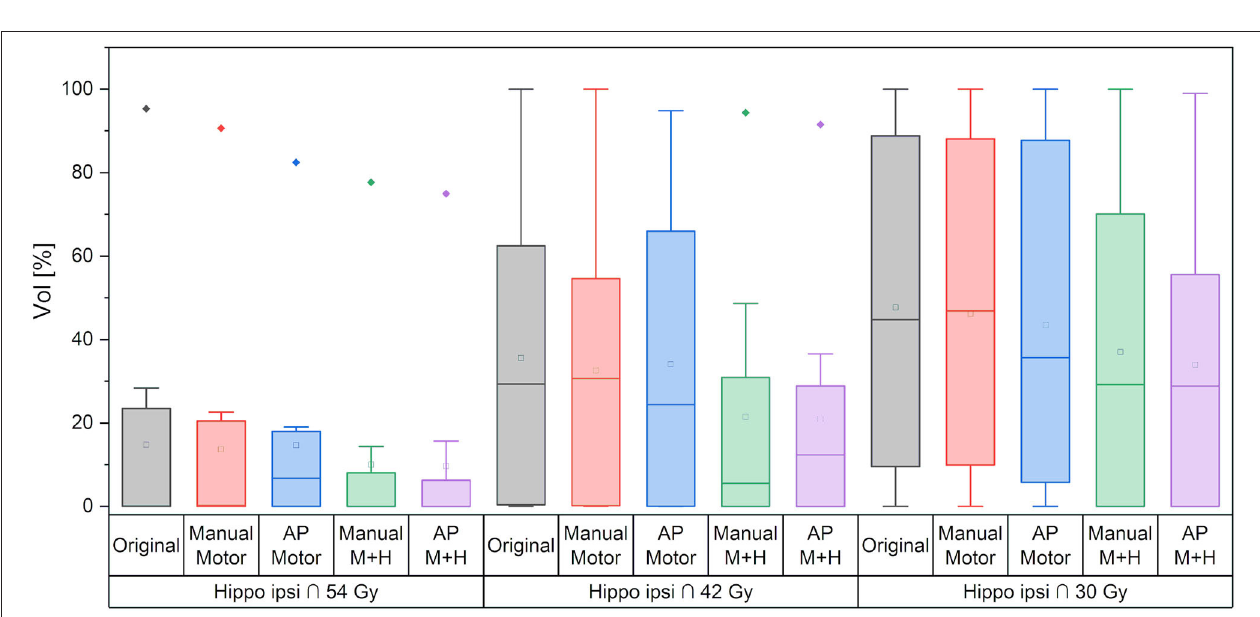
FIGURE 10 | Overlap of ipsilateral hippocampus and isodose levels. Line = median value, square = mean value, diamond = outliers, star = statistically significant p <